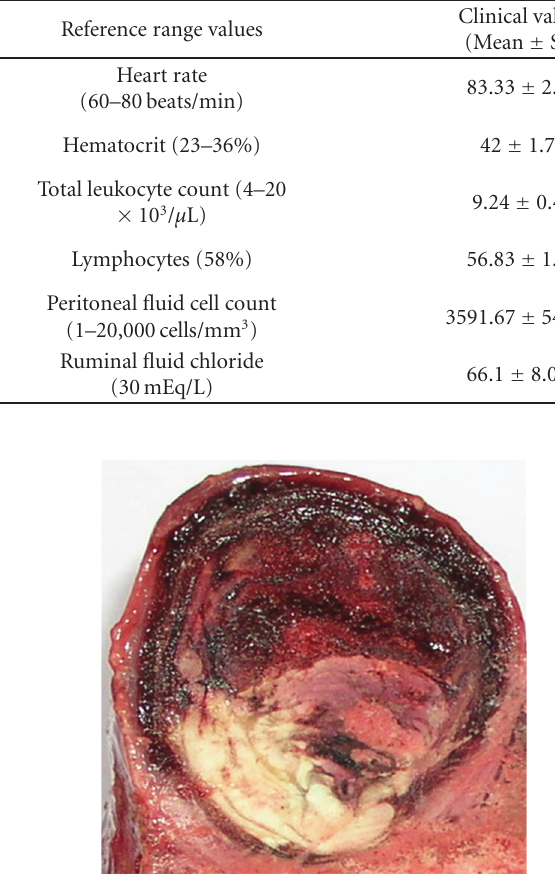
Figure 4: Frozen transverse section of an intussusception of